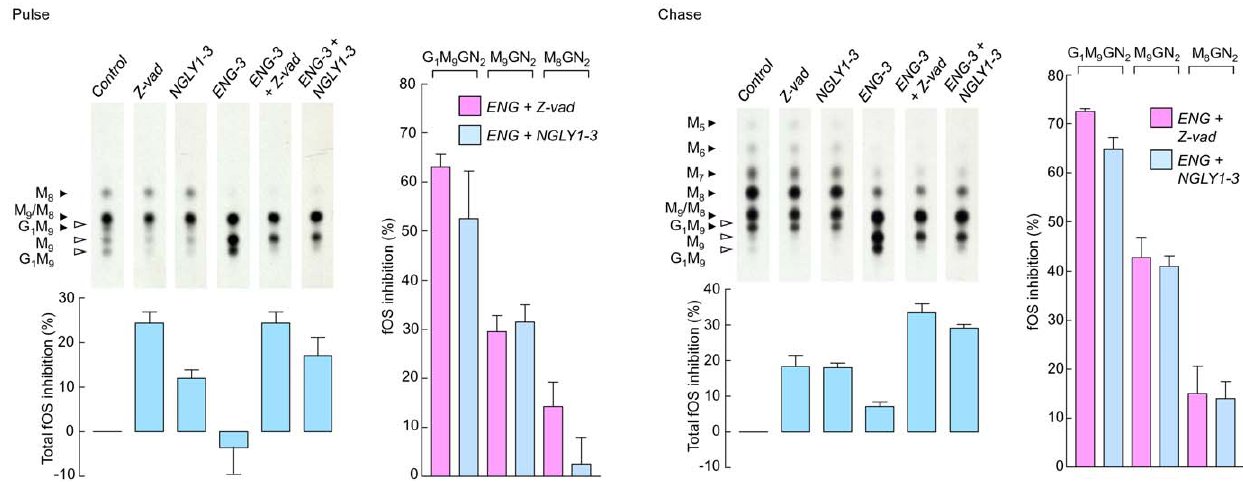
Figure 6. Quantitation of Ngly1p-dependent and -independent fOS pools in HepG2 cells. Cells were transfected with 50 pmoles of control siRNA ( Ctrl and Z-vad ), or 25 pmoles each of NGLY1-3 and 25 pmoles of control siRNA ( NGLY ), or 25 pmoles each of ENG-3 and 25 pmoles of control siRNA ( ENG ), or 25 pmoles each of NGLY1-3 and ENG-3 ( ENG + NGLY ). Three days after transfection, where indicated, cells were preincubated for 30 min with 40 m M Z-vad-fmk (Z-vad). Cells were then pulse-radiolabeled in either the absence or presence of Z-vad with [2- 3 H]mannose for 30 min (Pulse, left panels) or pulse-radiolabeled for 30 min prior to conducting a 1 h chase incubation (Chase, right panels). [2- 3 H]lipid-linked oligosaccharides, [2- 3 H] N -glycans released by EndoH from both cellular and medium glycoproteins and [2- 3 H]fOS were prepared and quantitated by scintillation counting. After summing the radioactivity associated with the above described fractions to generate total radioactivity incorporation into cells. [2- 3 H]fOS were examined by TLC. In order to take into account the differences in total incorporation of radiolabel into cells cultivated under the different conditions, the fraction of total fOS that was loaded onto the TLC was adjusted to take into account the ratio of the total cellular radioactivity for a given incubation to that recovered from the incubation incorporating least radioactivity. The migration positions of standard oligosaccharides are shown to the left of the chromatograms and the abbreviations used are as described in Fig 2. After elution of the oligosaccharide components from TLC plates and quantitation by scintillation counting, inhibition of total fOS appearance with respect to the control was calculated and is shown under the appropriate TLC lanes. The percentage inhibitions of individual oligosaccharides (Glc 1 Man 9 GlcNAc 2 : G 1 M 9 , Man 9 GlcNAc 2 : M 9 , Man 8 GlcNAc 2 : M 8 ) observed in the ENG + NGLY and ENG + Z-vad conditions with respect to the ENG condition are shown to the right of the chromatograms. The scanned TLC lanes are from the same fluorograph, but due to uneven migration, the scans were aligned manually to facilitate interpretation of data. This experiment was repeated 4 times and the error bars represent the standard deviation.